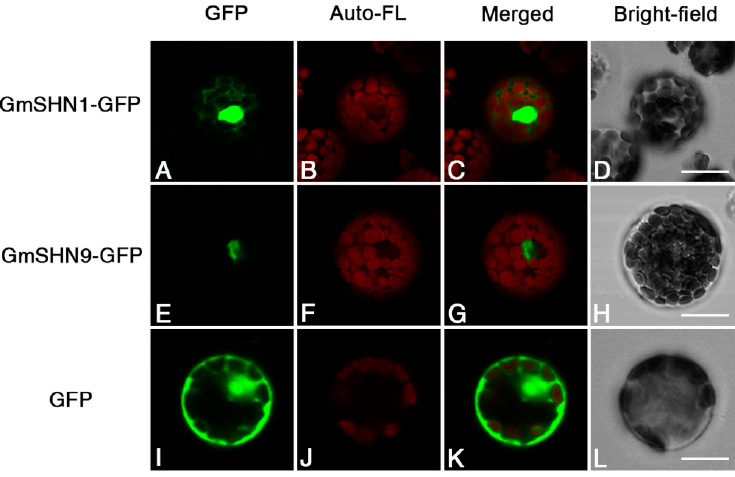
Figure 6. Subcellular localizations of GmSHN1 and GmSHN9. The green florescent protein (GFP) signals obtained by confocal microscopy indicated that fusion proteins GFP-GmSHN1 and GFP-GmSHN9 were localized primarily in the nucleus ( A , E ); and GFP protein was observed in both nucleus and cytosol ( I ); The chlorophyll auto fluorescent signals of protoplasts are indicated in images ( B , F , J ); The overlap of green fluorescent and chlorophyll auto fluorescent signals are indicated in merged images ( C , G , K ); Bright fields are showed in images ( D , H , L ). Scale bar = 20 µm.